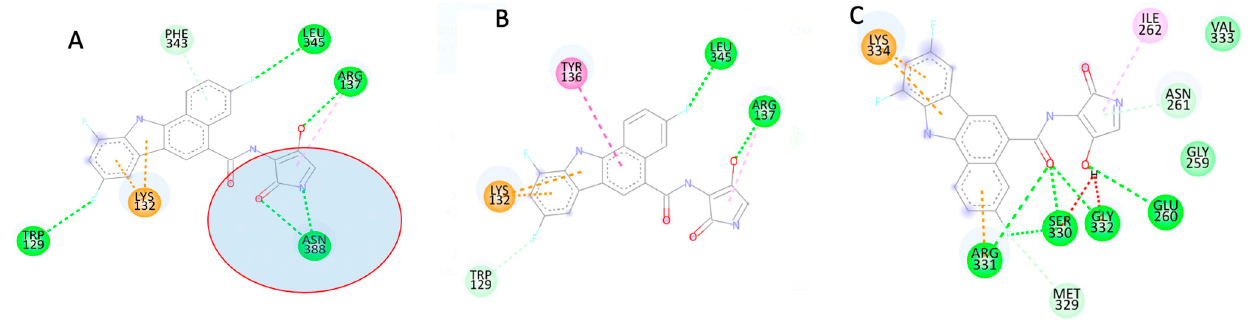
Figure 4. Two-dimensional structures of G0_APIND ( A ), G1_APIND ( B ), and G2_APIND ( C ) interactions.